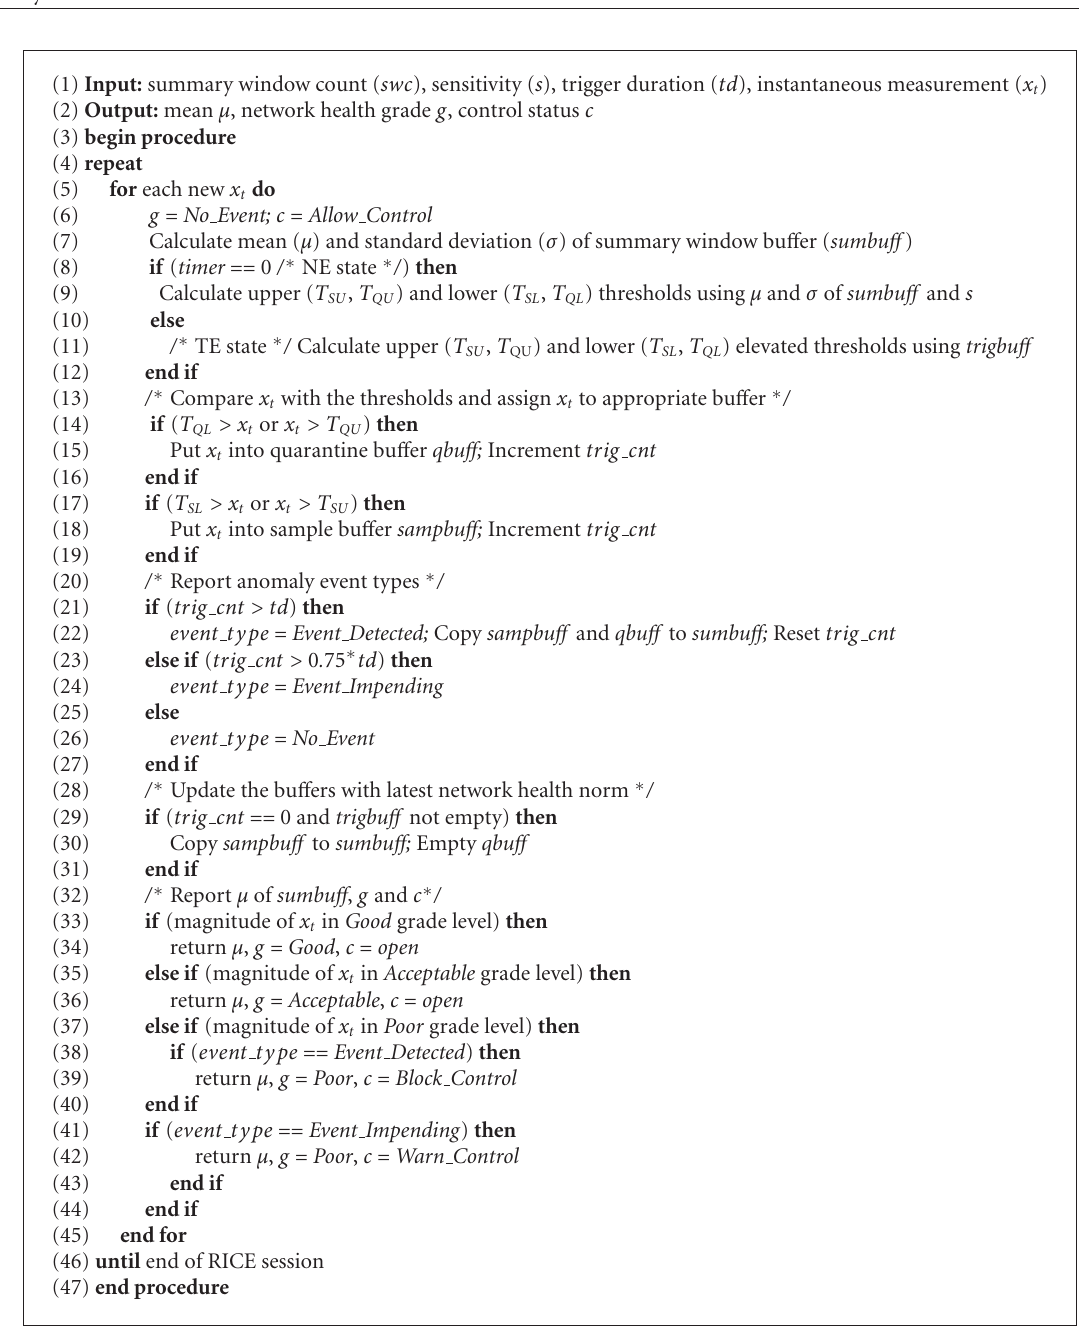
Algorithm 1: Plateau-detector algorithm implementation in